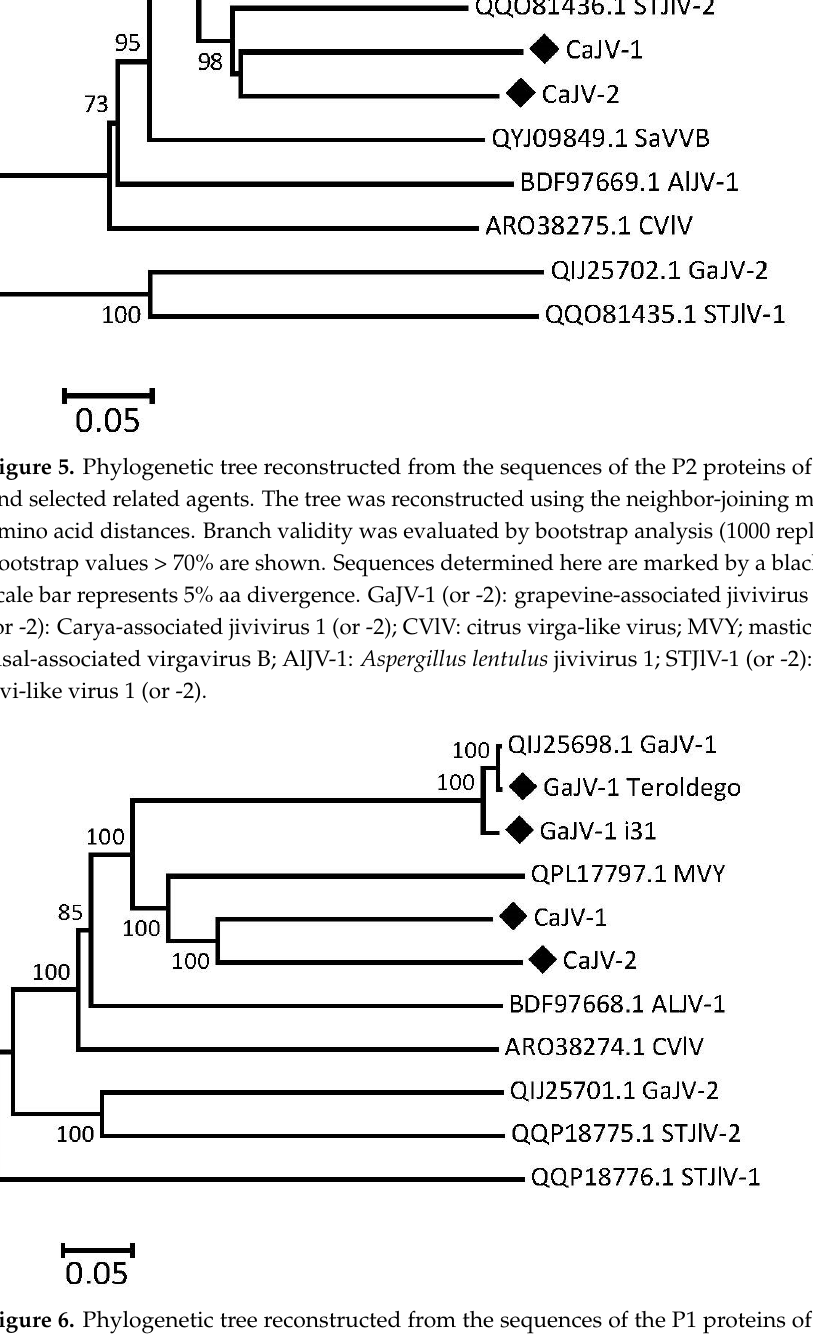
Figure 6. Phylogenetic tree reconstructed from the sequences of the P1 proteins of GaJV-1, CaJV-1 and selected related agents. The tree was reconstructed using the neighbor-joining method and strict amino acid distances. Branch validity was evaluated by bootstrap analysis (1000 replicates) and only bootstrap values > 70% are shown. Sequences determined here are marked by a black diamond. The scale bar represents 5% aa divergence. GaJV-1 (or -2): grapevine-associated jivivirus 1 (or -2); CaJV-1 (or -2): Carya-associated jivivirus 1 (or -2); CVlV: citrus virga-like virus; MVY; mastic virus Y; AlJV-1: Aspergillus lentulus jivivirus 1; STJlV-1 (or -2): soybean thrips Jivi-like virus 1 (or